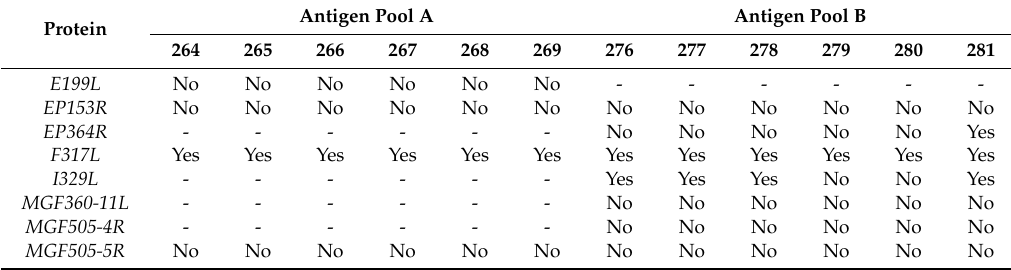
Table 2. Vero cells transfected with the individual antigens were stained with serum taken from the individual pigs before immunization or before the challenge. Wells were incubated with serum diluted 1:100 and anti-V5 antibody, then goat anti-pig and -mouse antibodies conjugated to Alexa Fluor 488 and 568 respectively. A pig was considered positive for a given antigen if the pre-immunization sera were negative and the pre-challenge sera were positive. A dash indicates the sample was not tested against this